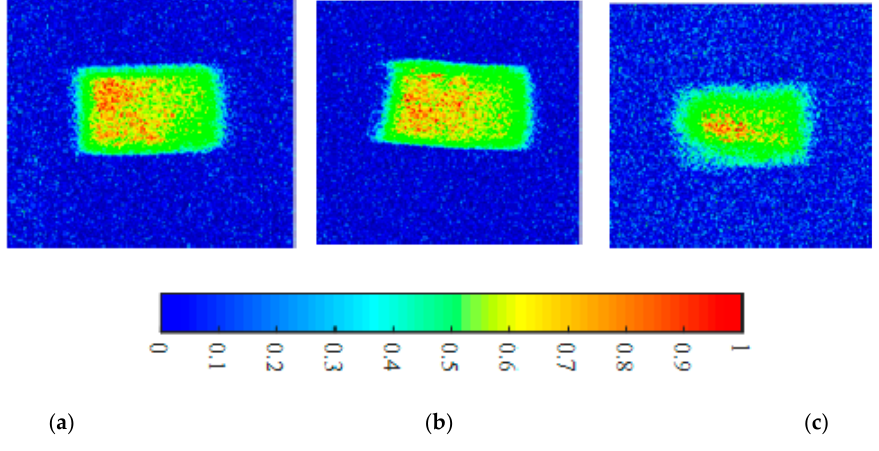
Figure 12. The magnetic resonance imaging of QT-1 sample: ( a ) 0 h, ( b ) 6 h and ( c ) 23 h. 246